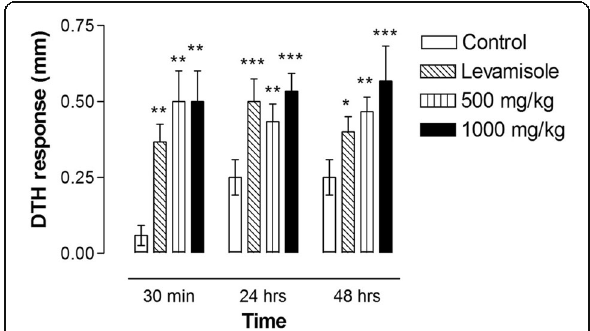
Fig. 1 Effect of T. clypeatus on DTH response using CRBC as an antigen in mice. Histogram represent Means ± SD ( n = 5). Means